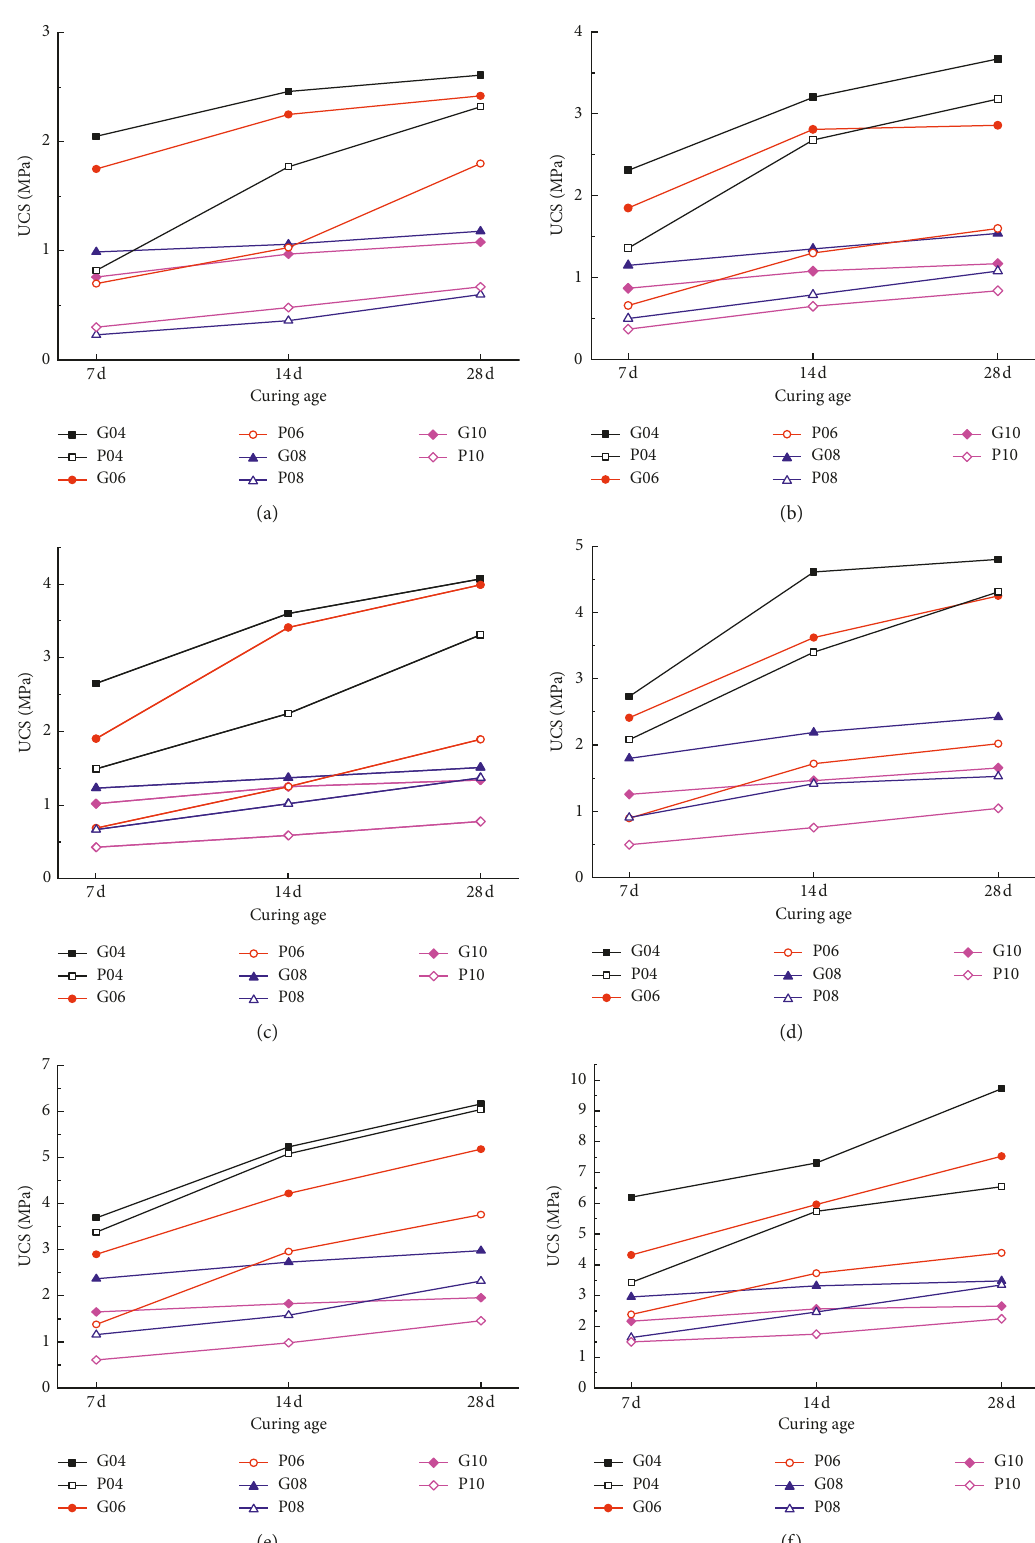
Figure 4: Diagram of CTB strength growth: (a) mass concentration 65%; (b) mass concentration 68%; (c) mass concentration 70%; (d) mass concentration 72%; (e) mass concentration 75%; (f) mass concentration